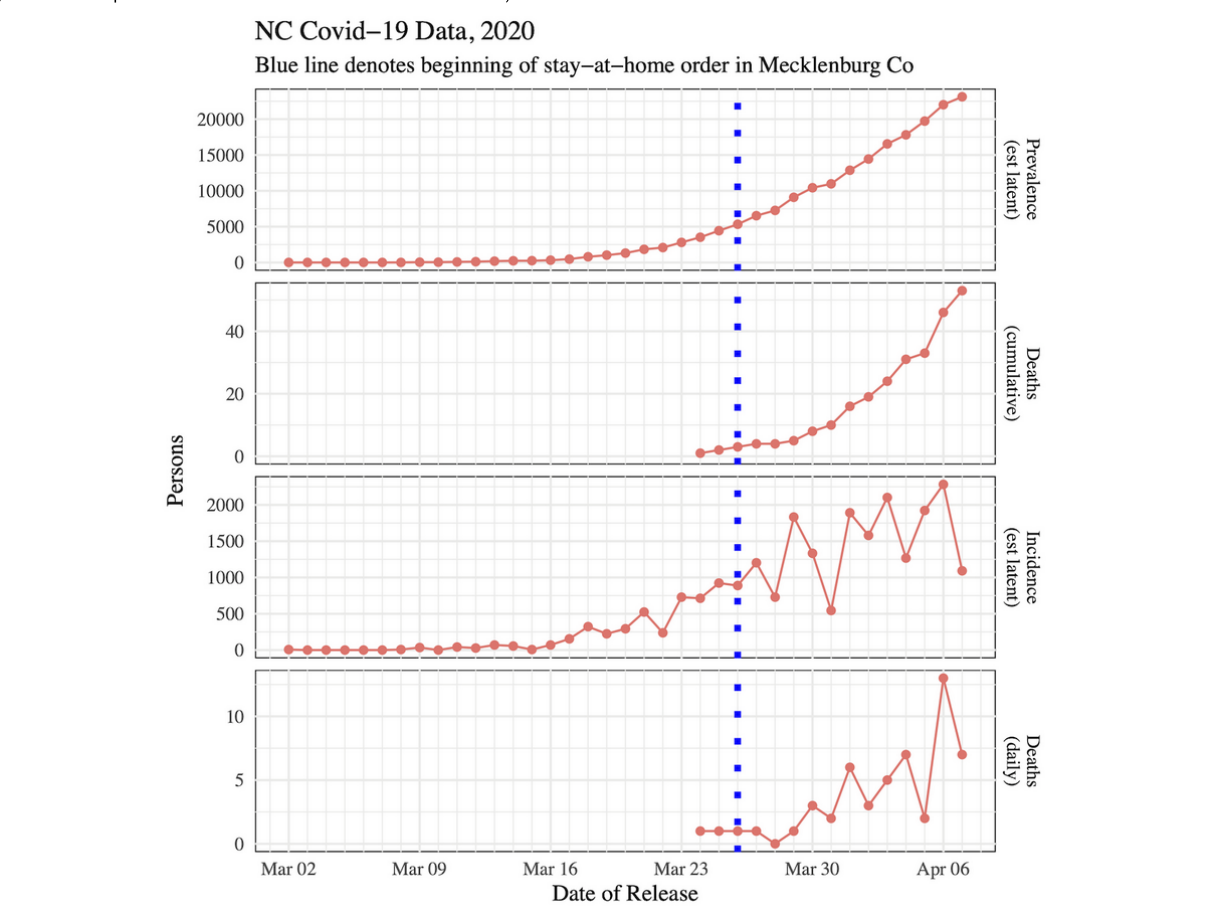
Figure 3. Time plots for NC. COVID-19: coronavirus disease; NC: North